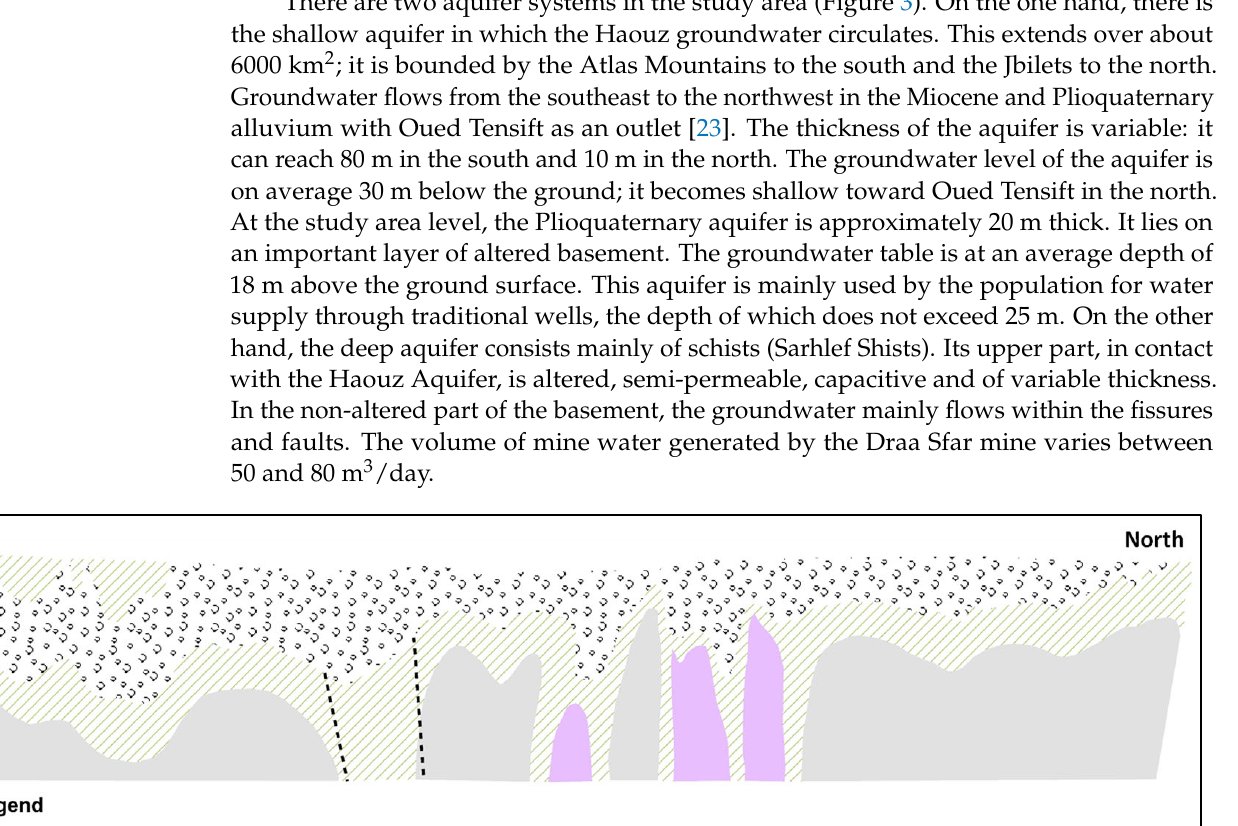
Table 1. Conservative elements concentrations in shallow aquifer and mine groundwater.